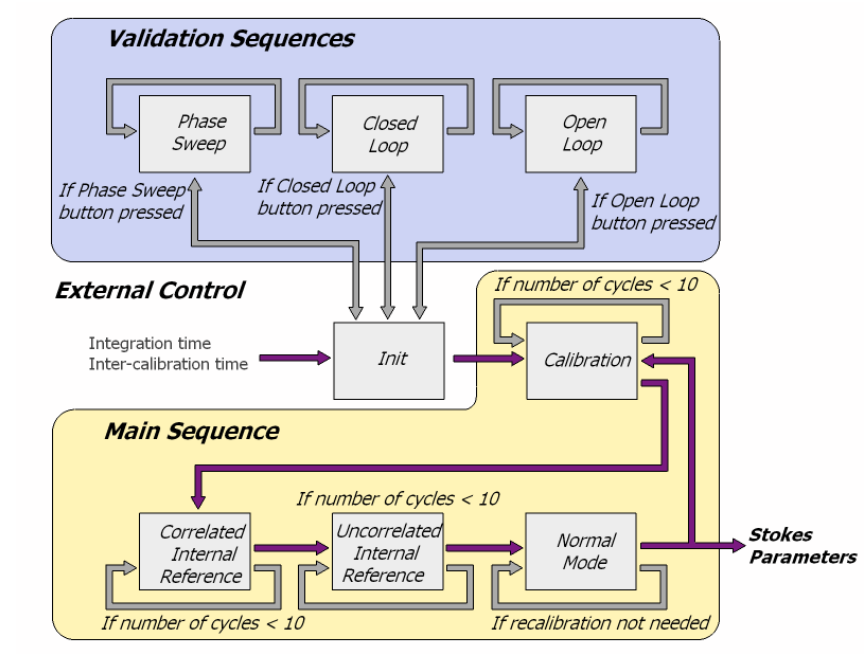
Figure 13. CU finite states machine diagram and